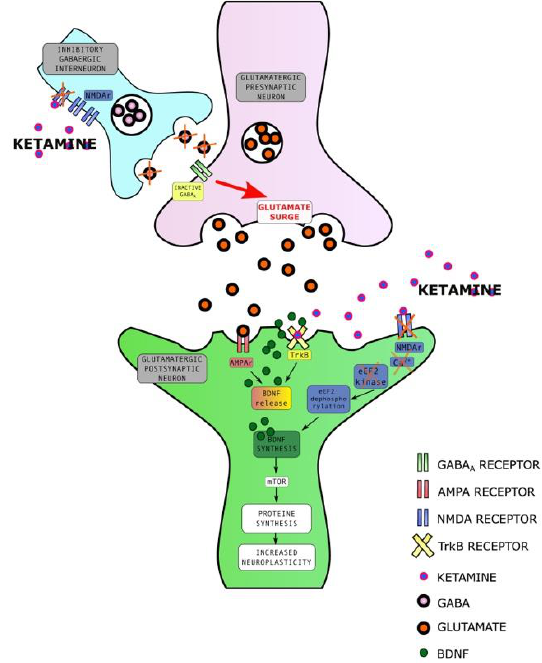
Figure 2. Molecular mechanisms of rapid antidepressant and neuroplastic effect of ketamine. NMDAR— N-methyl D-aspartate receptor, GABA A R—gamma-aminobutyric acid A receptor, AMPAR— α -amino-3-hydroxy-5-methyl-4-isoxazolepropionic acid receptor, BDNF—brain derived neurotrophic factor, m-TOR—mammalian target of rapamycin, Ca 2+ —calcium ions, EF2K—eukaryotic elongation factor 2 kinase, EF2—eukaryotic elongation factor 2, TrkB—tyrosine receptor kinase B .